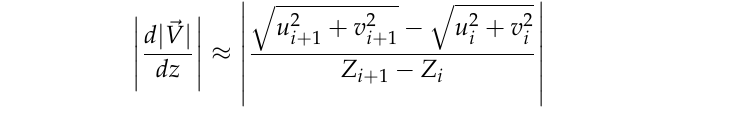
where u and v are the zonal and meridional components, i is the background level, and Z is altitude. GK2A IR winds have a negative PD at the pressure level of 600–800 hPa, which is consistent with the region with a slow wind speed bias except for the tropics region, as shown in Figures 4 and 5. In addition, it can be seen that the speed bias and RMSVD are large in the region where the strong vertical wind shear and the PD are located together. H-8 AMVs, which have similar observational coverage to those of GK2A, show some weak negative PD near the jet stream and at the low level, but do not show as clear a negative wind speed bias as the GK2A (see Figure